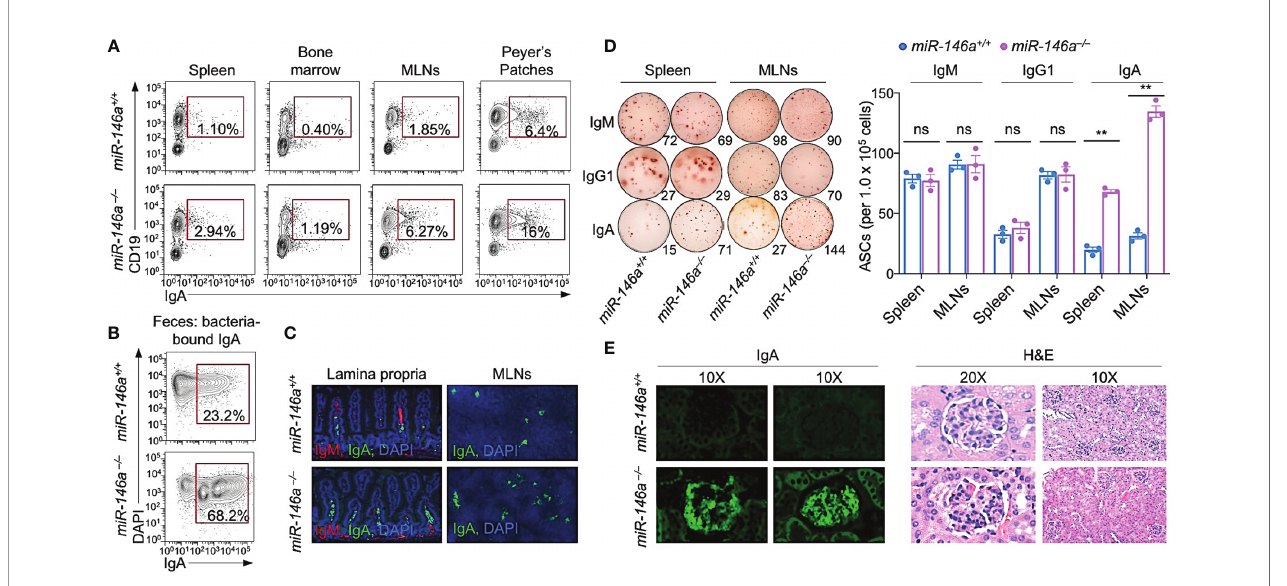
FIGURE 1 | miR-146a – / – mice (12 wk of age) displayed elevated systemic and gut IgA + B cells, IgA-secreting cells, and kidney IgA deposition, as hallmark of IgA nephropathy. (A) IgA + B cells in spleen, bone marrow, mesenteric lymph nodes (MLNs) and Peyer ’ s patches as analyzed by fl ow cytometry. (B) Fecal bacteria- bound IgA as analyzed by fl ow cytometry. (C) IgM + and IgA + B cells in the lamina propria and MLNs of miR-146a and miR-146a +/+ mice as visualized by fl uorescence microscopy. (D) ELISPOT analysis of IgM-, IgG1- and IgA-secreting cells (ASCs) in spleen and MLNs. (E) Photomicrographs of kidney sections from miR-146a – / – and miR-146a +/+ mice, after fl uorescence staining for mouse IgA (left) or hematoxylin and eosin (H&E) staining (right). Data are from one representative of three independent experiments yielding similar results; or mean ± SEM of 3-4 miR-146a – / – or miR-146a +/+ mice from three independent experiments ( D , right panel).